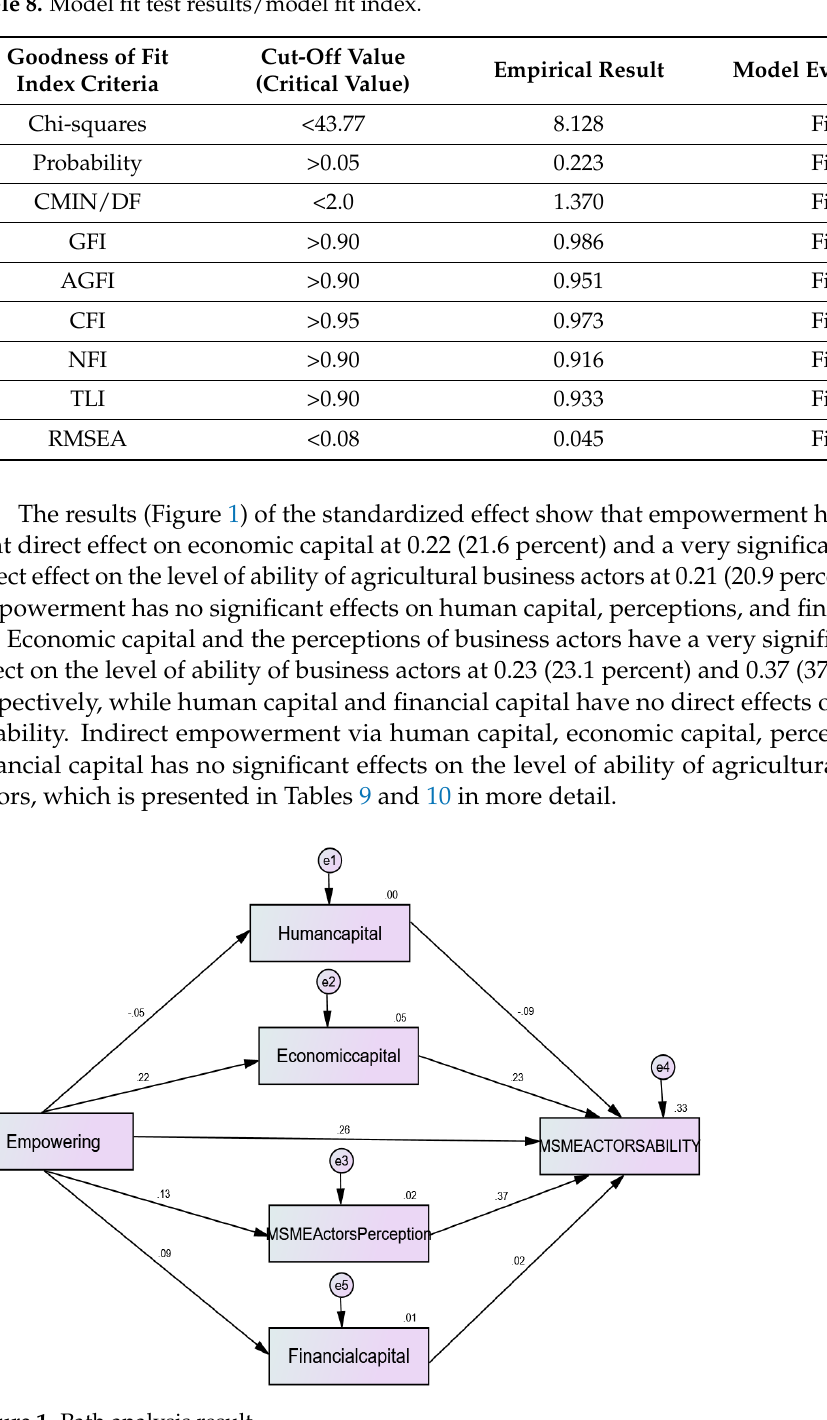
Figure 1. Path analysis result. Table 9. Direct effect path analysis test results.